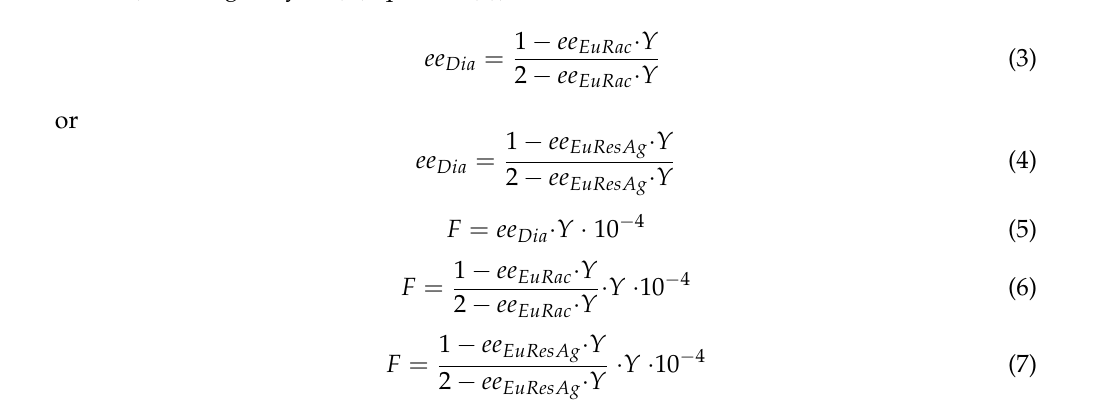
Figure 6. When racemic AcMA is resolved with ( R )- FA resolving agent, the configurations do not change; however, the more favorable ee Dia is the result of the thermodynamic control.